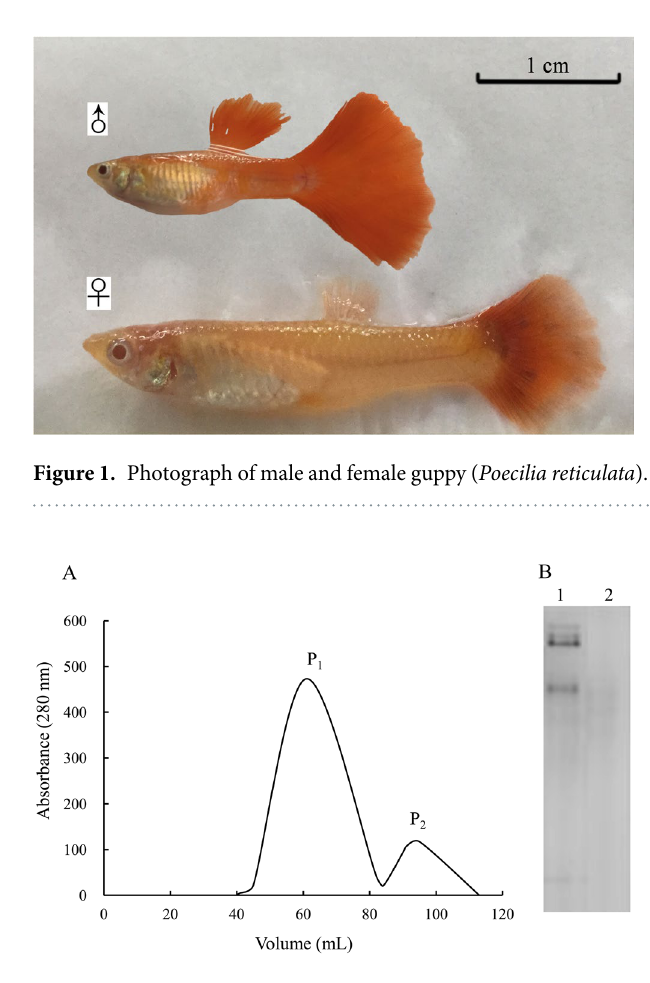
Figure 2. Elution profiles of ovarian homogenates on a Sephacryl S-300 column ( A ) and Native-PAGE (4–7.5%) detection of peak elution ( B ). lane 1, Peak P 1 ; lane 2, Peak P 2